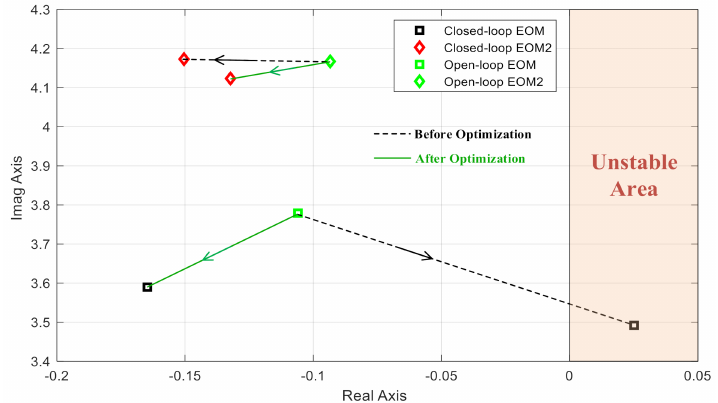
Figure 13. Modal shifts of system EOMs with/without optimization strategy.